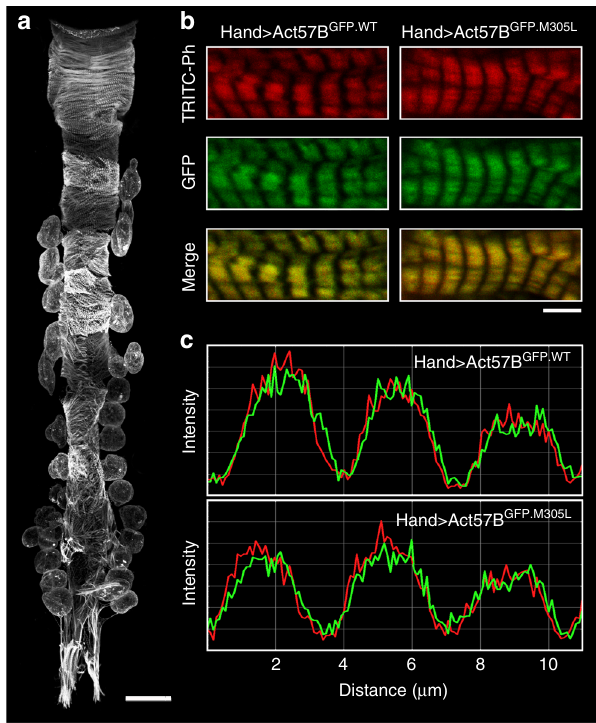
Fig. 1 M305L actin incorporates evenly along Drosophila cardiac thin fi laments. a Composite confocal image of a full-length Hand > Act57B GFP.WT adult Drosophila heart tube. Four micrographs were acquired at ×40 magni fi cation and computationally stitched together. Scale bar = 100 µ